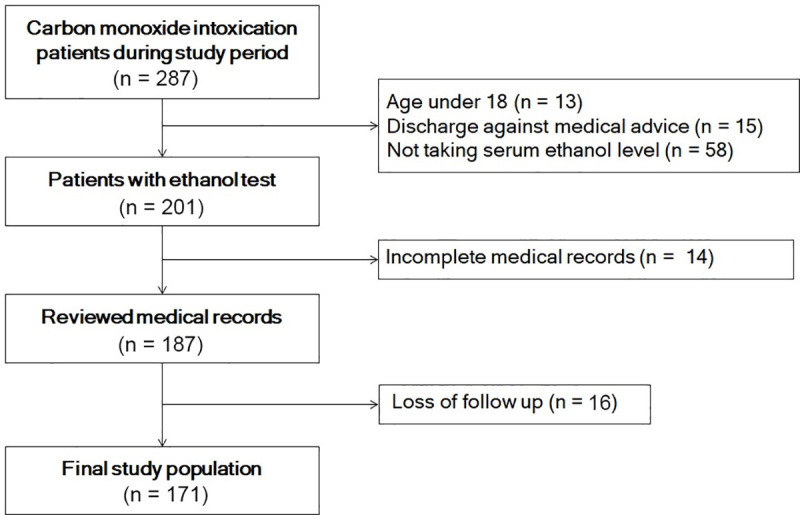
Study population.